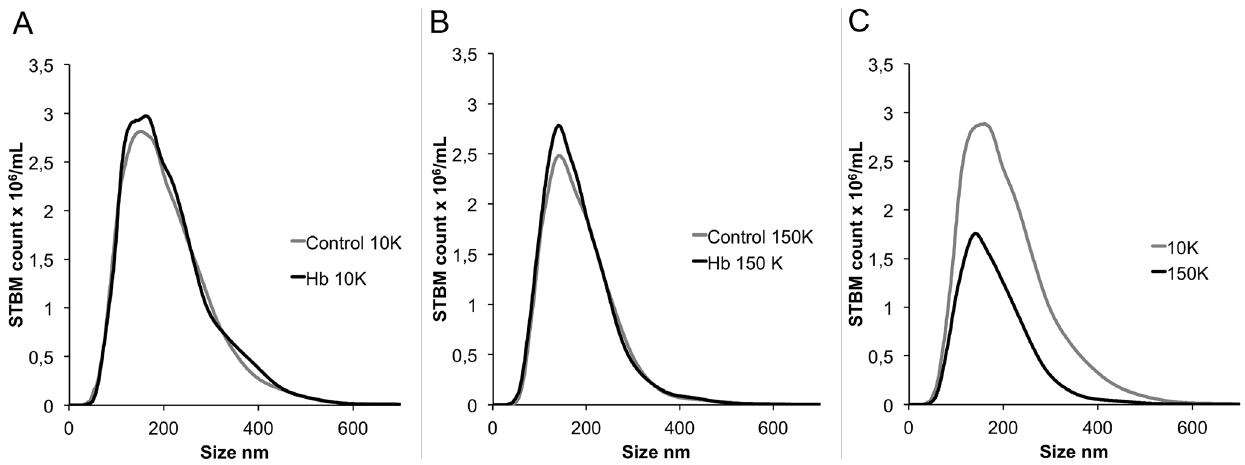
Figure 2. NTA analysis of vesicle size distribution in the 10K and 150K fraction. Nanoparticle tracking analysis (NTA) size distribution profiles for STBMs; comparing effect of Hb perfusion for 10K (A) and 150K (B) STBMs. In (C) the effect of centrifugation speed, 10K vs 150K, is compared. 10K STBMs had a significantly larger median size than 150K STBMs. doi:10.1371/journal.pone.0090020.g002 PLOS ONE |